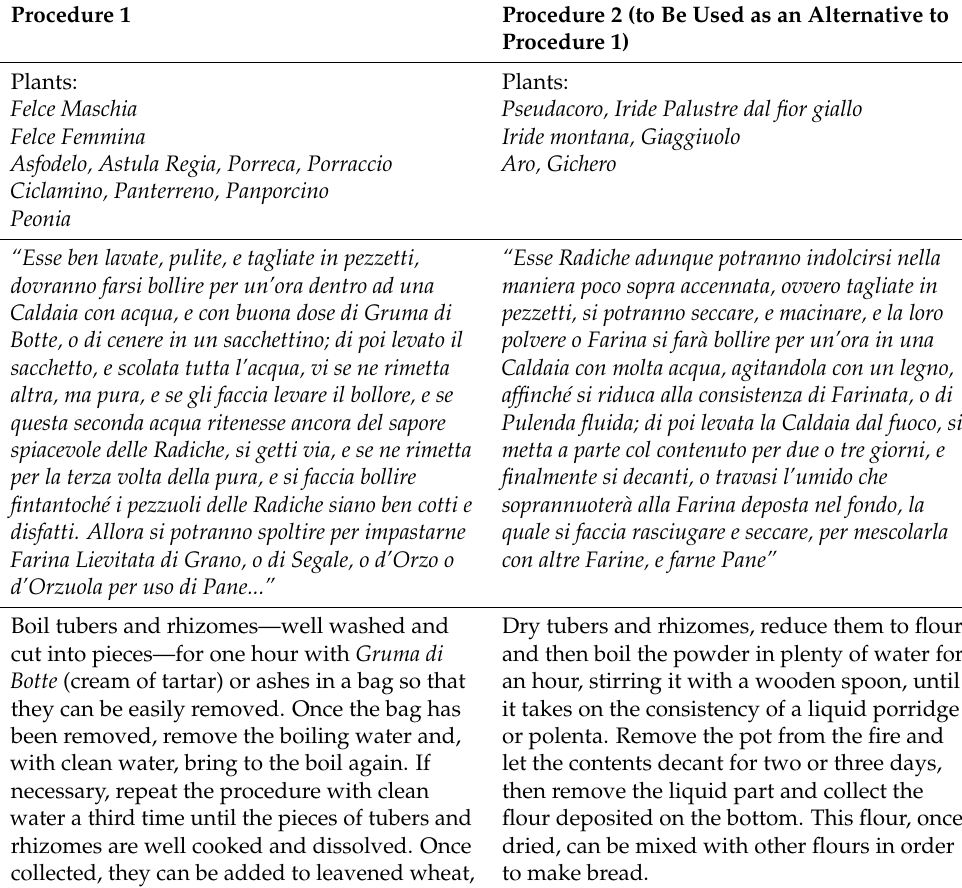
Table 1. The two procedures described by Giovanni Targioni Tozzetti [6] (p. 11) to eliminate toxic substances from the rhizomes and tubers of the eight toxic plants